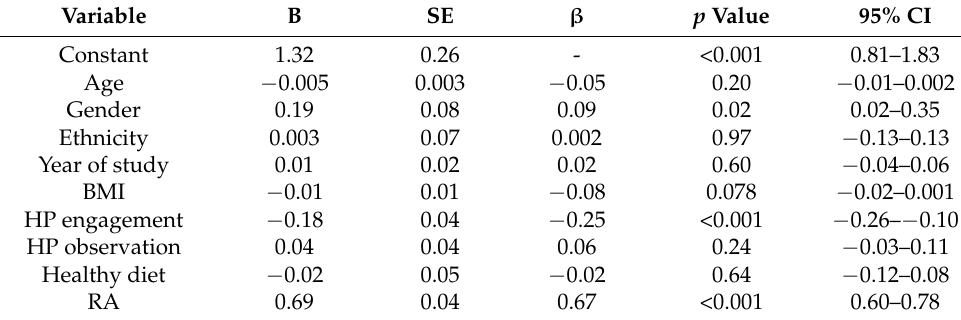
Table 4. Linear regression model predicting ATHPP ( n =